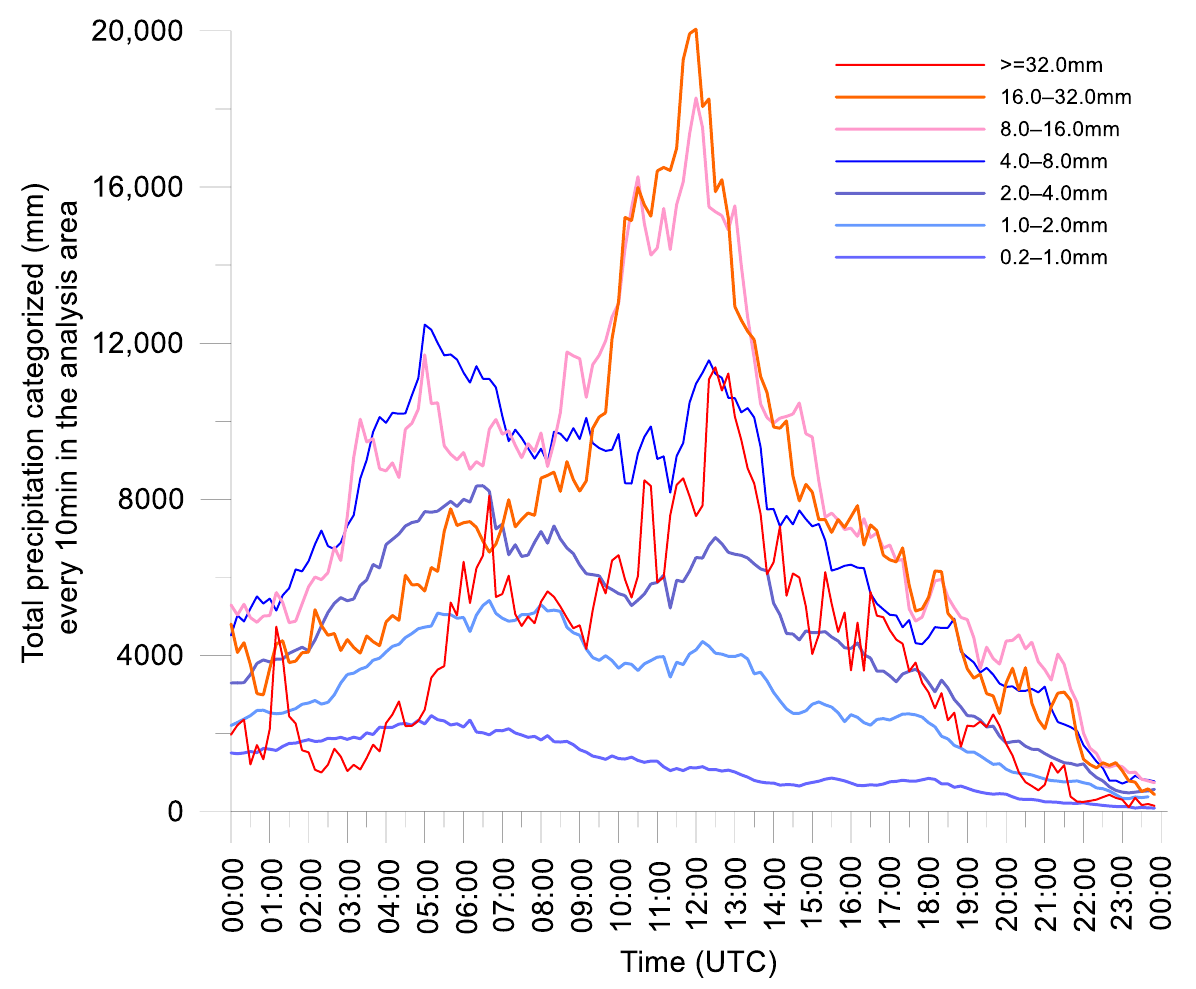
Figure 2. The time sequence of total precipitation inside the analysis area for each category. The warm and cold colors indicate precipitation of more than 8.0 mm and 0.2–8.0 mm, respectively. We defined the precipitation under 8 mm/h as weak precipitation and over 8 mm/h as strong precipitation and calculated the total amount of strong and weak precipitation every 10 min. Focusing on the time sequences of strong and weak precipitation, we studied the relationship between sprite emission and precipitation.